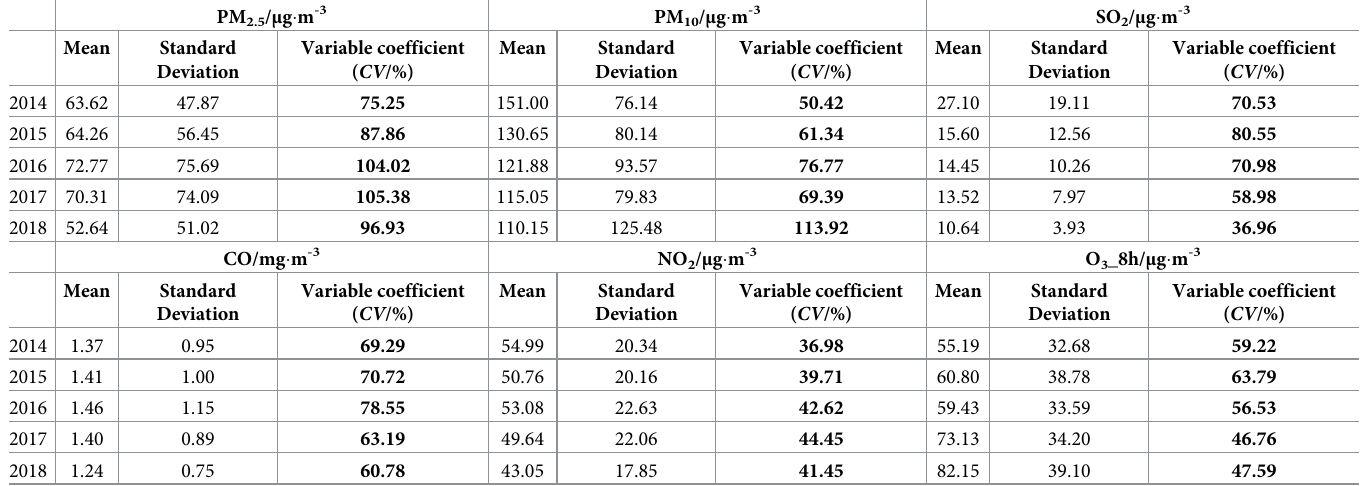
Table 2. The Statistical characteristics of variation of main pollutant concentrations in